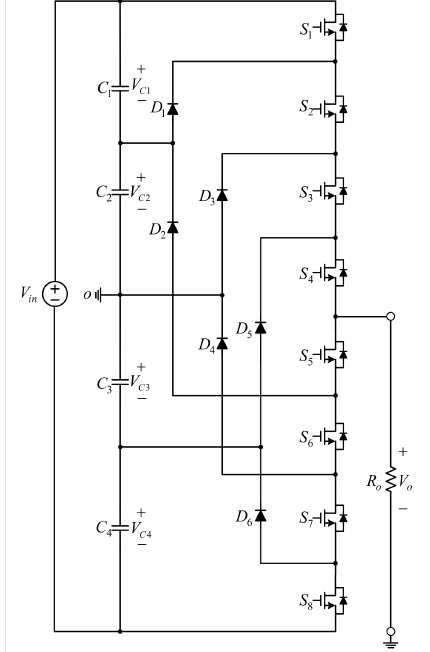
Figure 2. Circuit structure of a five-level neutral point clamped inverter. Status I [ V o = 0]: As displayed in Figure 3, switches S 1 , S 2 , S 7 , and S 8 are cut off, while the switches S 3 , S 4 , S 5 , and S 6 are on, so the output voltage V o is zero.